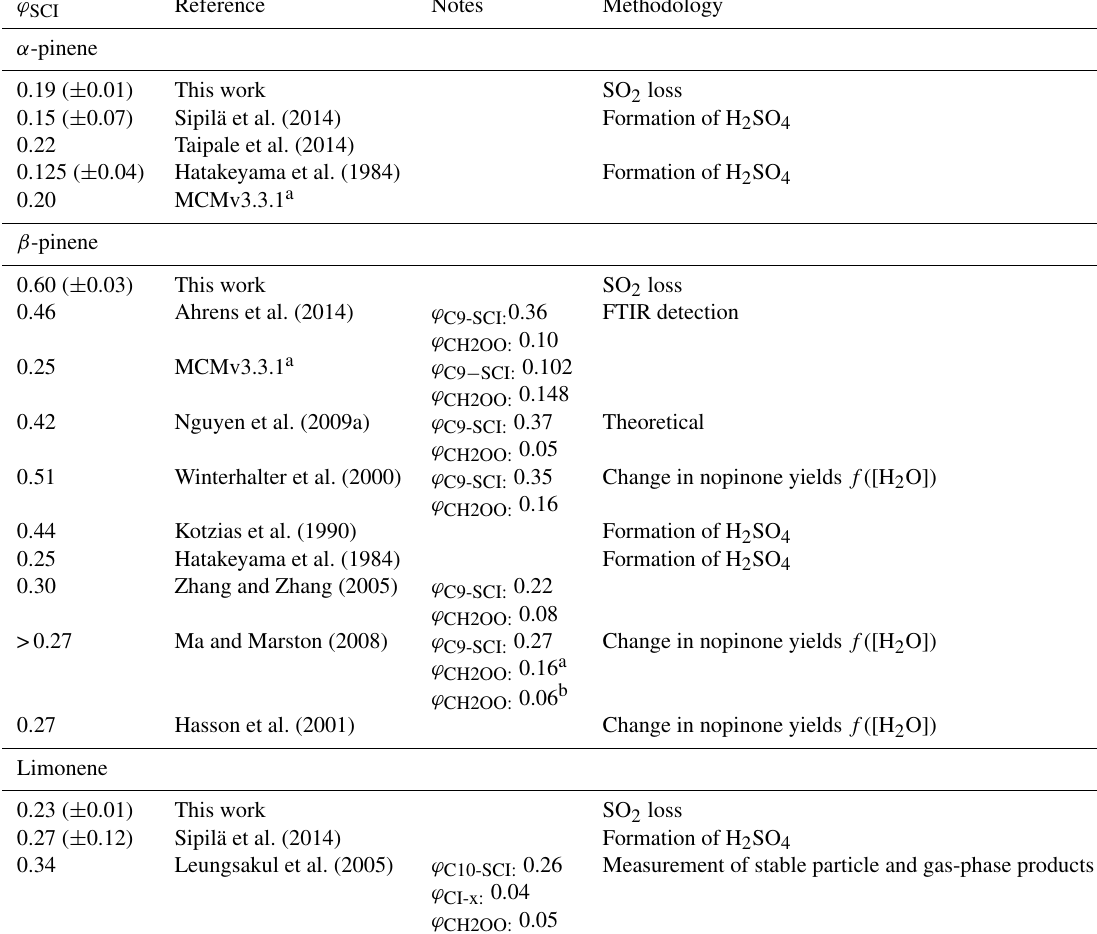
Table 1. Monoterpene SCI yields derived in this work and reported in the literature. ϕ SCI Reference Notes Methodology